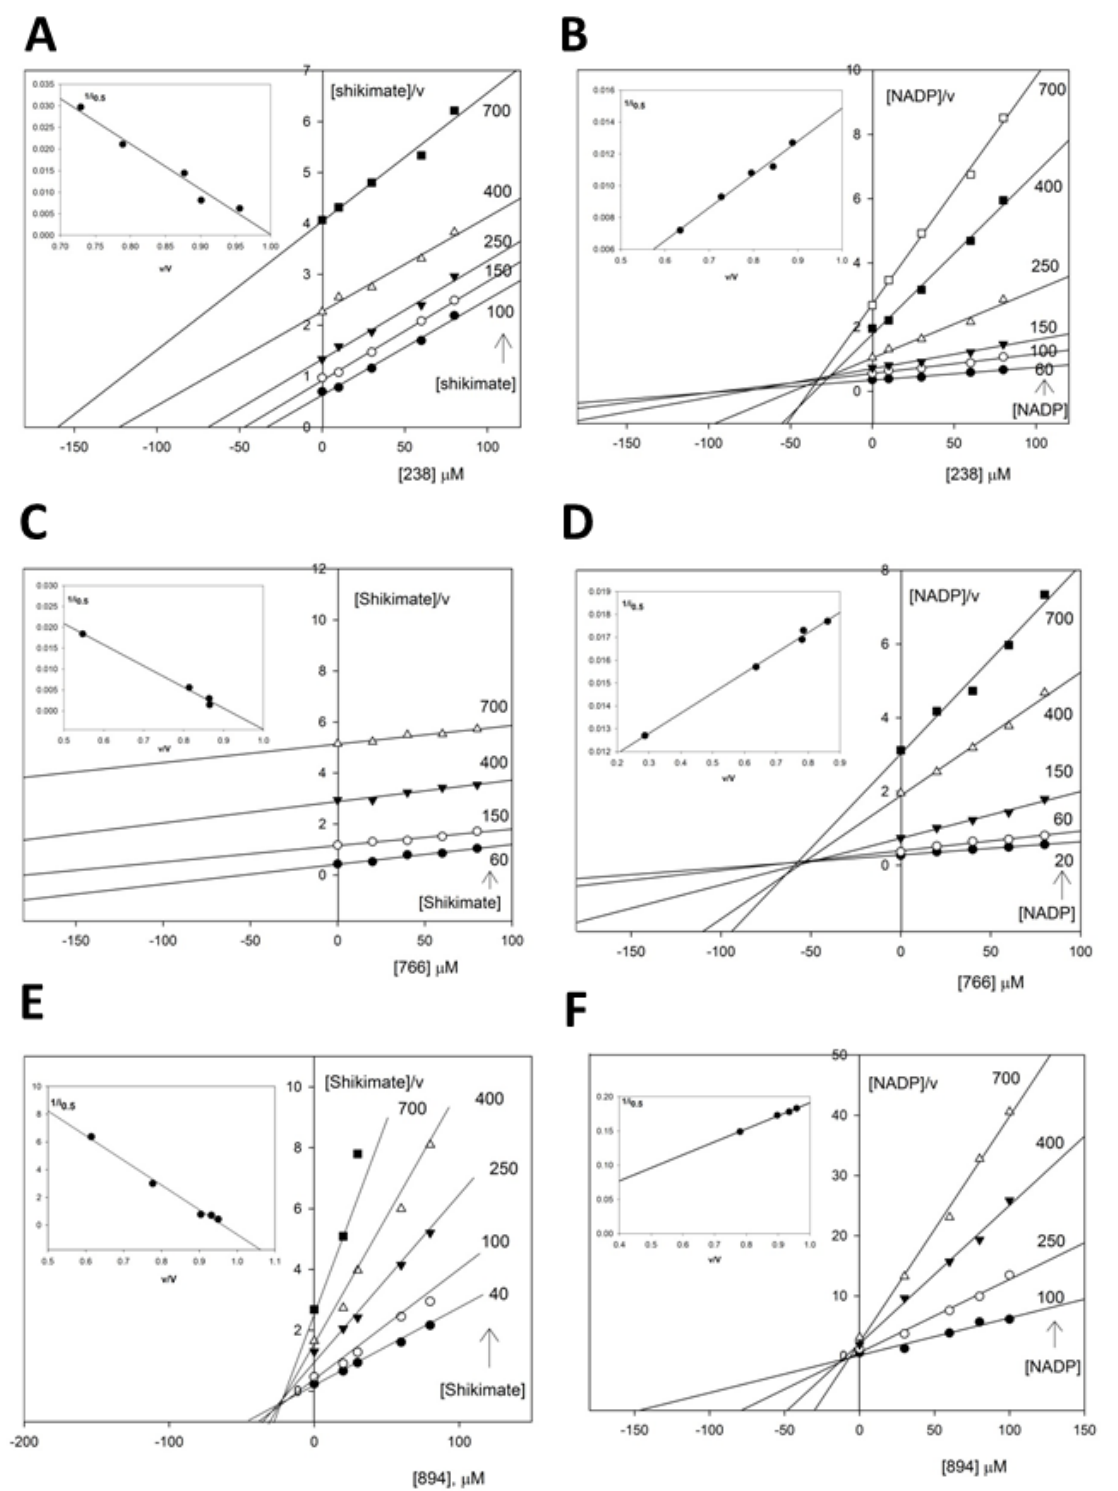
Figure 4. SaSDH inhibition patterns by compounds 238 ( A and B ), 766 ( C and D ) and 894 ( E and F ). A Cornish-Bowden plot was drawn using the data obtained from the kinetic studies in order to confirm the inhibition pattern and the inhibition constants ( (cid:1837) were determined by interpretation of the 1 (cid:1861) maximal velocity and the velocity in the absence and presence of the inhibitor with a given concentration of the substrate,